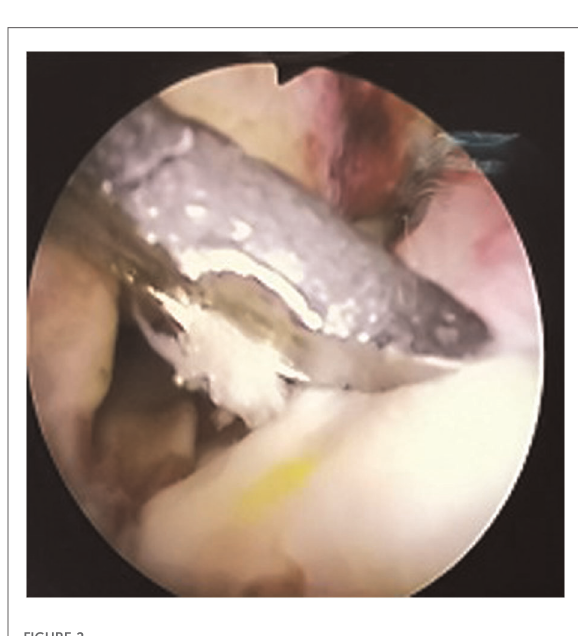
FIGURE 2 Arthroscopic view: reduction of fracture block with reducer.